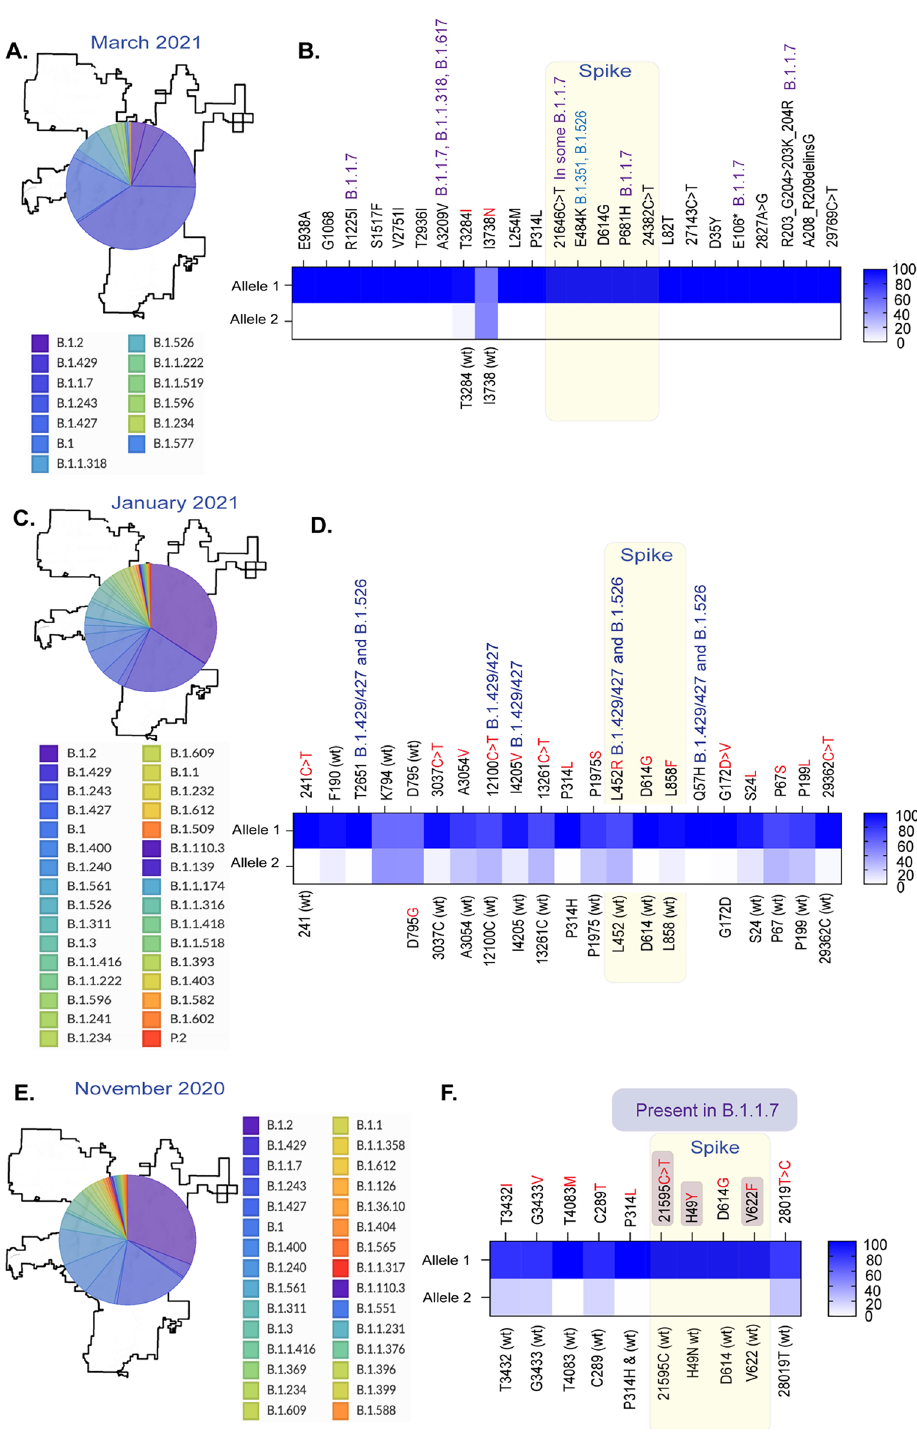
Figure 5. Detection of SARS-CoV-2 variants specific signatures in wastewater and their correlation with circulating variants identified through individual level testing for three months. ( A ) Relative abundance of SARS-CoV-2 variants in the Washoe county detected through individual level testing during March 2021. ( B ) Variant defining mutations of the SARS-CoV-2 genome detected in the wastewater during March 2021. ( C ) Relative abundance of SARS-CoV-2 variants in the Washoe county detected through individual level testing during January 2021. ( D ) Variant-defining mutations of the SARS-CoV-2 genome detected in the wastewater during January 2021. ( E ) Relative abundance of SARS-CoV-2 variants in the Washoe county detected through individual level testing during November 2020. ( F ) Variant defining mutations of the SARS-CoV-2 genome detected in the wastewater during November 2020. Figure generated using NextStrain (https:// nexts train. org) 20